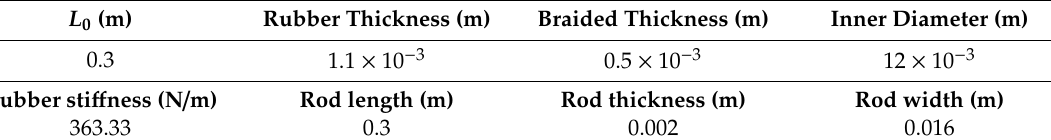
Table 2. The dimensions of the bending pneumatic muscle actuator (PMA).